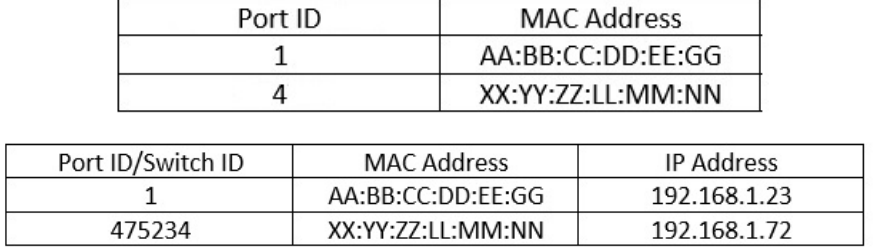
Figure 2. Traditional Content Addressable Memory (CAM) table and a modified CAM